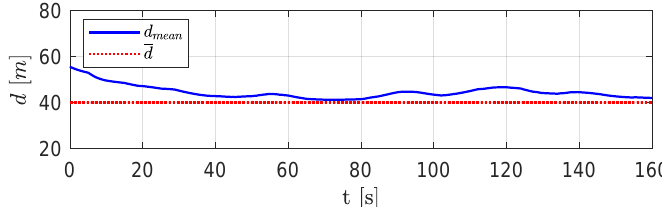
Figure 19. Scenario #1—10 aircraft: mean distance between visible aircraft (blue solid line), compared with desired distance (red dotted